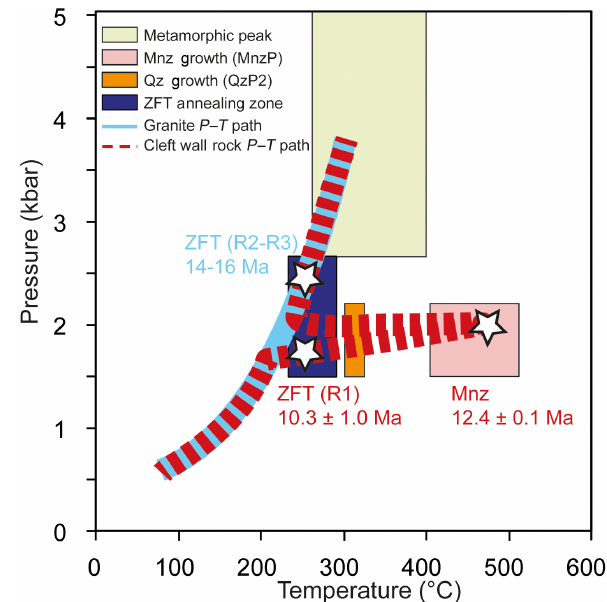
Figure 8. Pressure–temperature ( P – T ) path for the Lauzière granite host rock and in the hanging wall of the Alpine-type cleft. Metamor- phic peak conditions are not well constrained in the Lauzière massif, and are based on a compilation of metamorphic and geochronolog- ical data in the external massifs from the Western Alps (Rolland et al., 2003; Rossi et al., 2005; Simon-Labric et al., 2009; Bel- langer et al., 2015). Geochronological constrains provided in this study are represented by stars. The zircon fission track (ZFT) ther- mochronometer fixes the cooling of the granite (R2-R3) and the cleft (R1) below 240–280 ◦ C. Microthermometric and geochrono- logical results on monazite (Mnz) are assumed to represent the on- set of hydrothermal activity (red box), while the main hydrothermal growth phase is based on a microthermometric study of the fluid inclusions in quartz